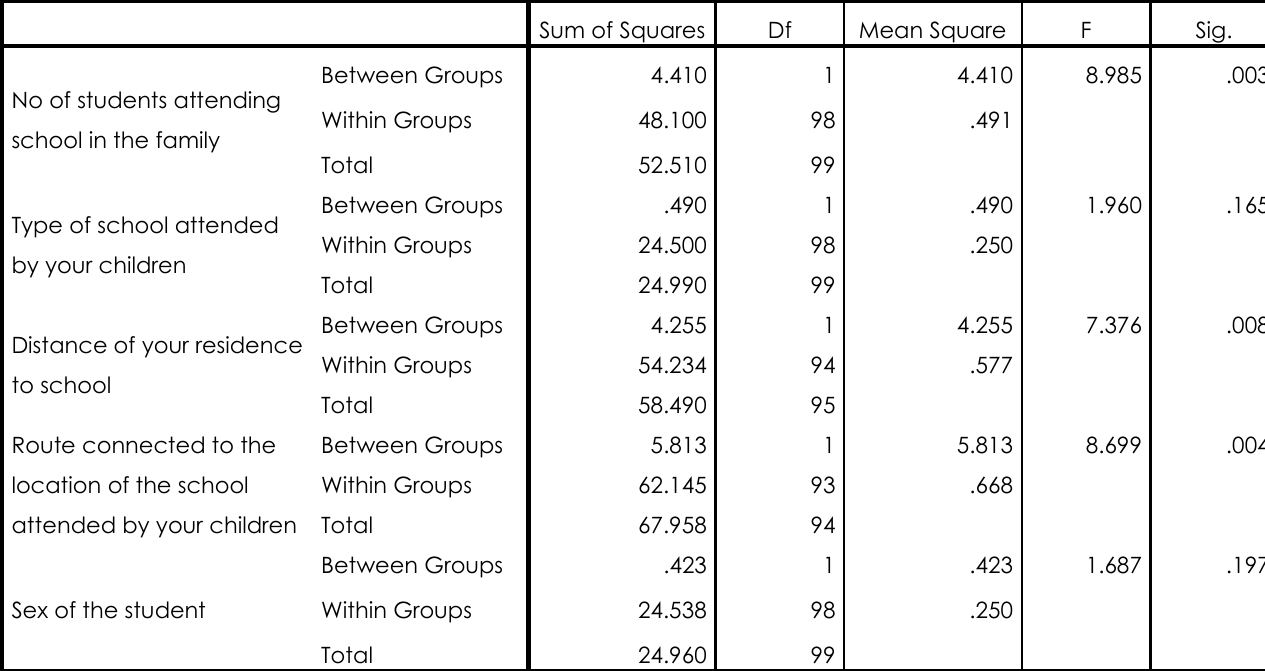
Table 3: Variables that Determine whether Children Walk to School in Lokoja